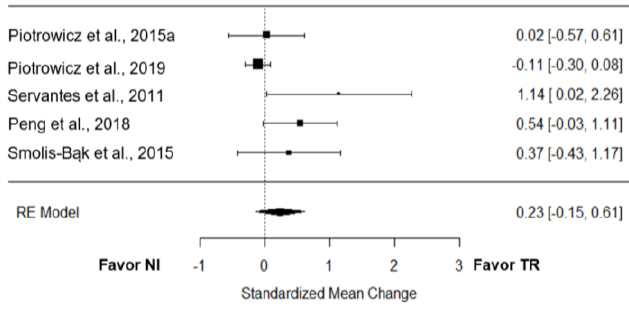
Figure 5. Effect of TR on QoL compared to NI [21,22,24,27,28].